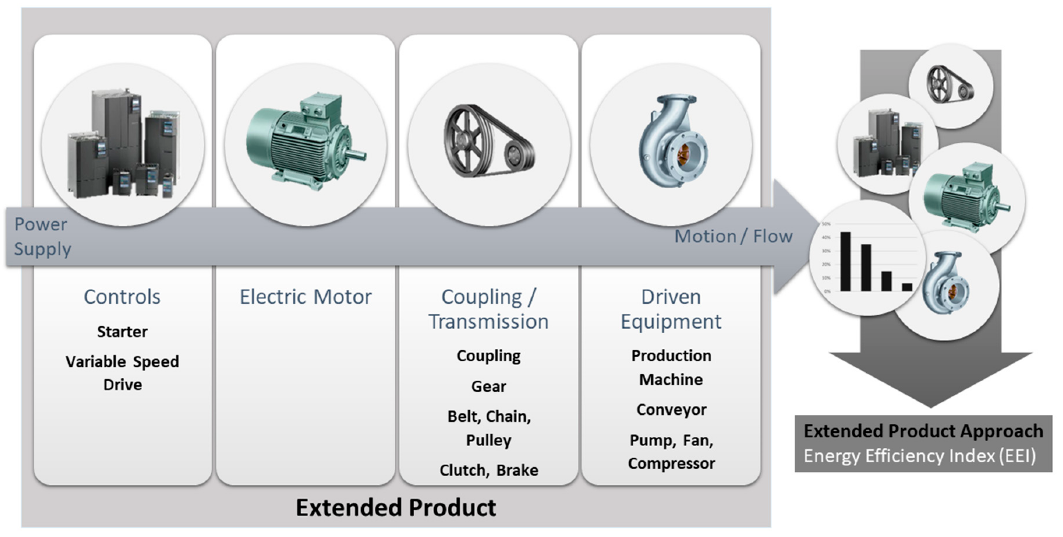
Figure 5. The Extended Product Approach.